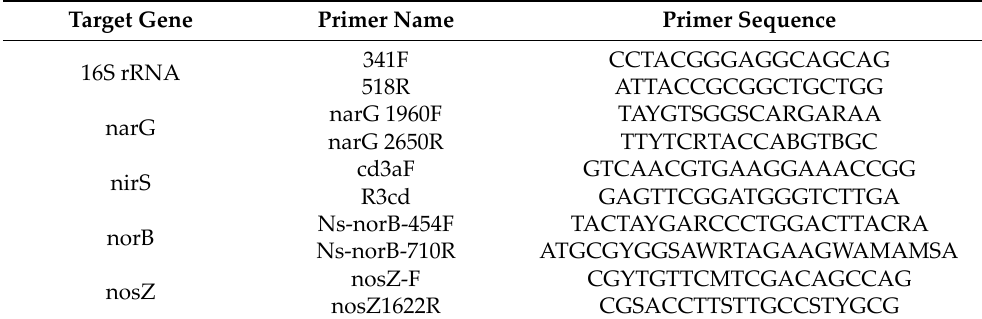
Table 1. The sequences of specific primers in real‑time qPCR